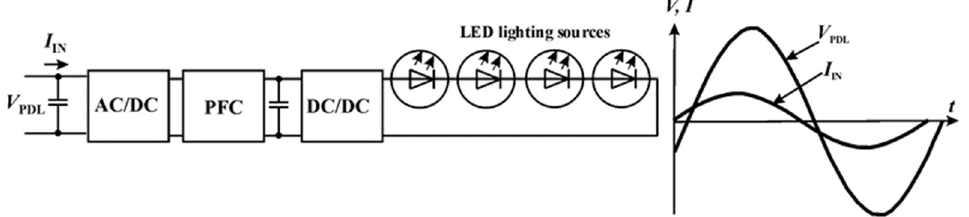
Figure 3. Time diagrams of the voltage and current of diode rectifier supply-side devices with power factor correction function.